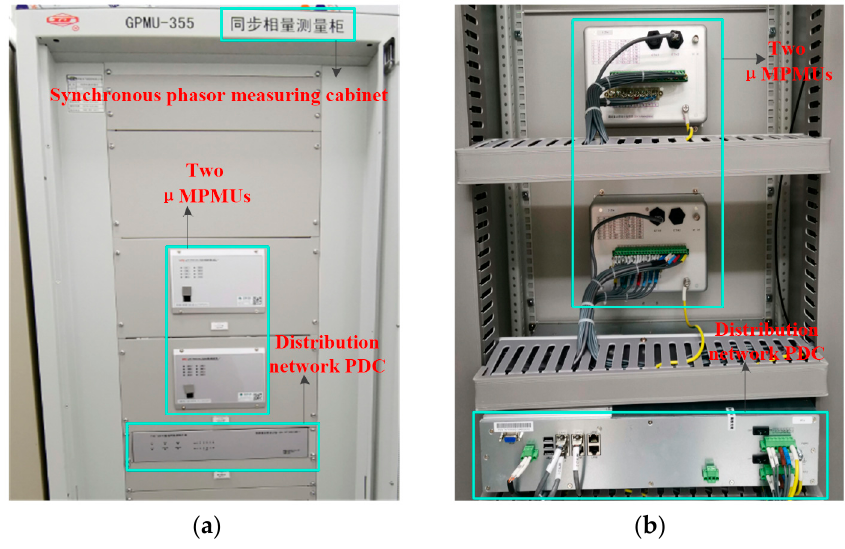
Figure 16. Field installation diagram. ( a ) Front side; ( b ) back side wiring.